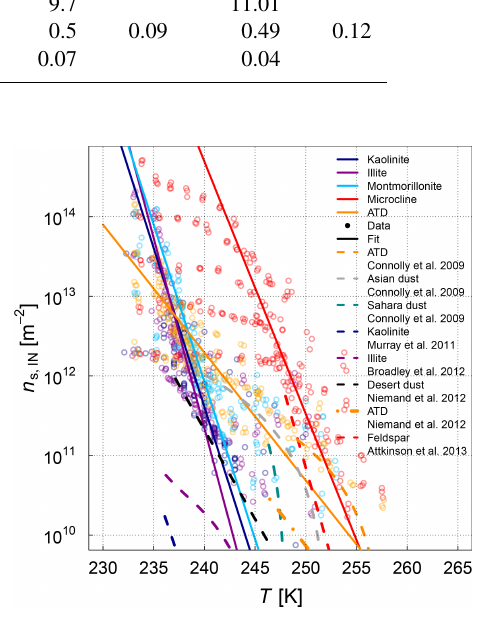
Table C1. Derived fit parameters for two different CNT formulations based on the complete kaolinite dataset or subsets of the data. The values are rounded to two digits after the decimal point. The RMSE value is the deviation of the fit to the complete dataset. No. Fit parameter All data RMSE Only RMSE Only RMSE Only one RMSE size time dataset 2 f 0.29 0.14 0.29 0.14 0.3 0.14 0.23 0.15 (cid:49)g # / 10 − 20 J 9.95 9.93 9.7 11.01 5 µ 0.5 0.09 0.5 0.1 0.5 0.09 0.49 0.12 σ 0.06 0.05 0.07 0.04